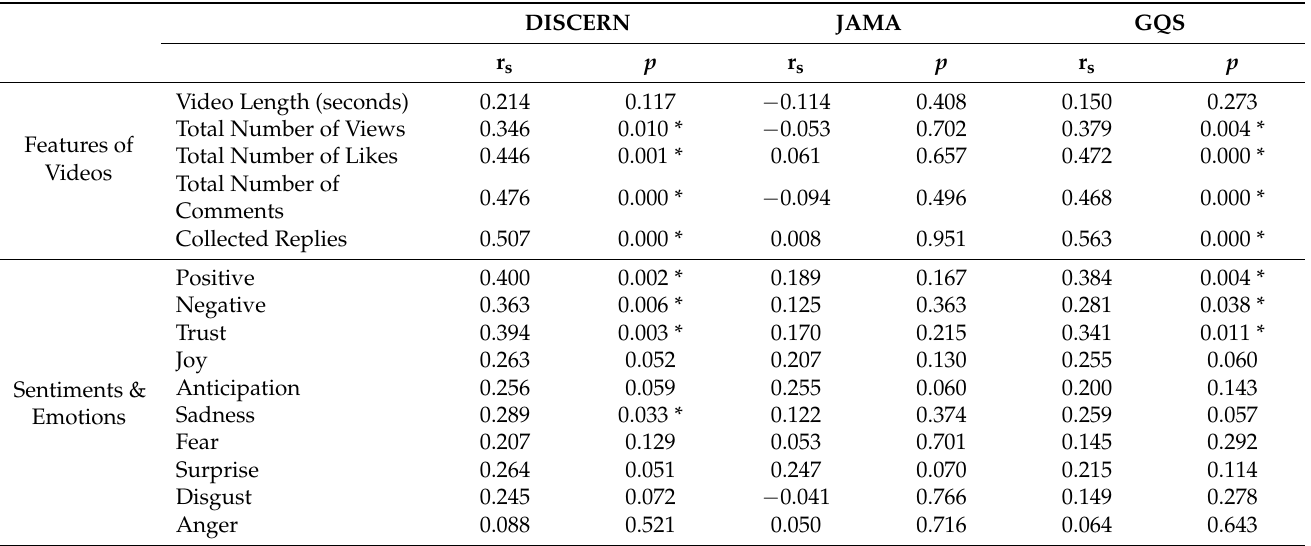
Table 3. Correlations between features of videos and sentiment–emotion scores with the DISCERN, JAMA, and GQS scoring systems. DISCERN